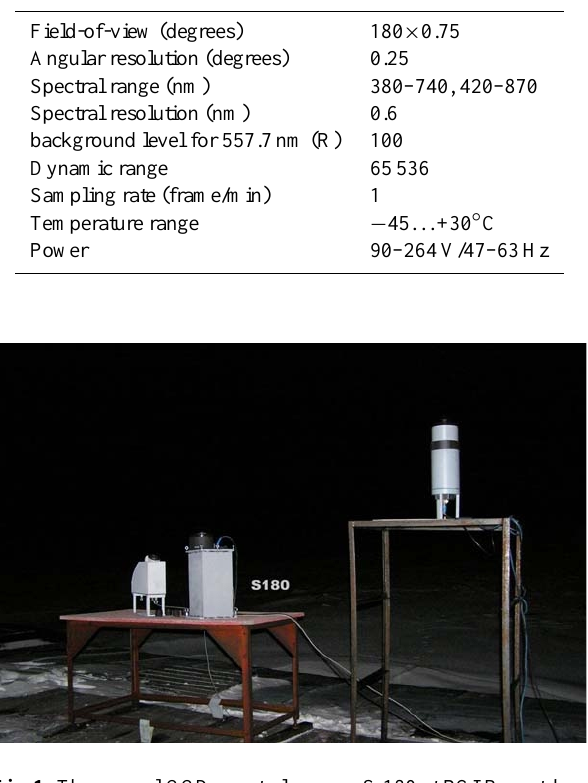
Fig. 1. The auroral CCD spectral camera S-180 at PGI Barentsburg observatory.